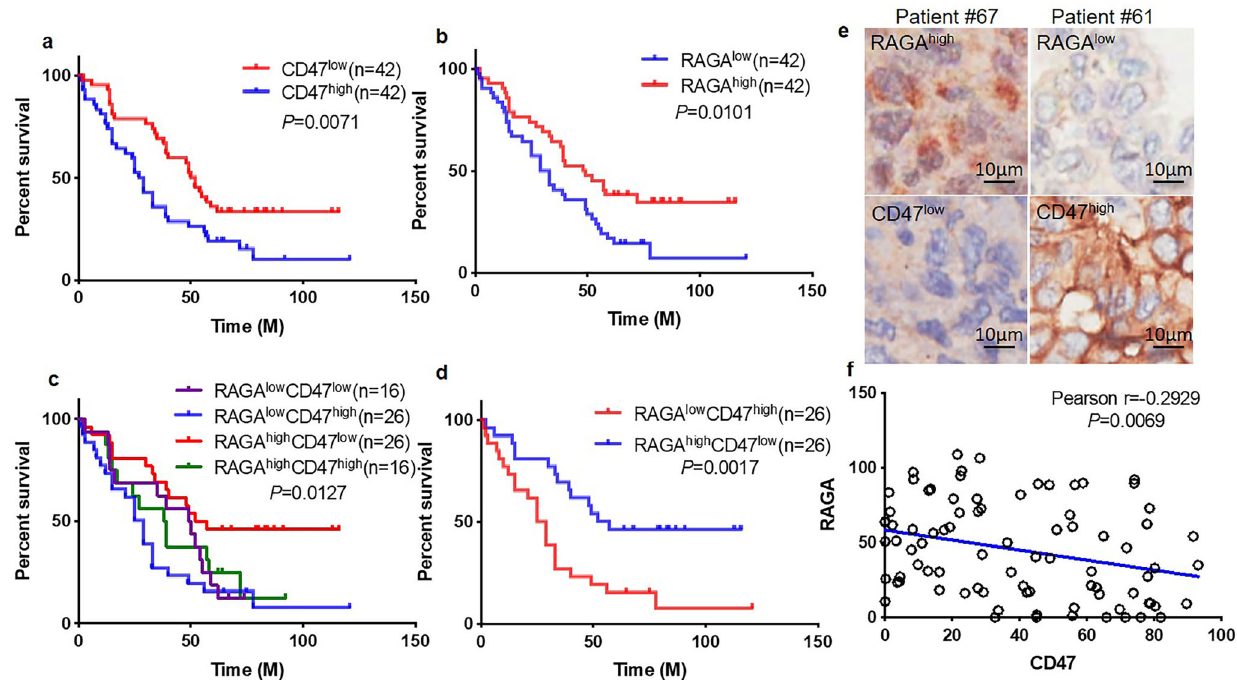
Fig. 6 Clinical relevance of RAGA/CD47 axis. a Overall survival analysis of 84 lung adenocarcinoma patients with low and high CD47 protein expression. P = 0.0071. b Overall survival analysis of 84 lung adenocarcinoma patients with low and high RAGA protein expression. P = 0.0101. c Overall survival analysis of 84 lung adenocarcinoma patients with RAGA high CD47 high , RAGA high CD47 low , RAGA low CD47 high , and RAGA low CD47 low protein expression. P = 0.0127. d Overall survival analysis of lung adenocarcinoma patients with RAGA high CD47 low and RAGA low CD47 high protein expression. P = 0.0017. e Representative immunohistochemistry staining of RAGA high CD47 low and RAGA low CD47 high patient samples. f Pearson correlation coef fi cient analysis of RAGA and CD47 expression in 84 lung adenocarcinoma patients. Pearson r = − 0.2929. P = 0.0069. P < 0.05 is considered statistical signi